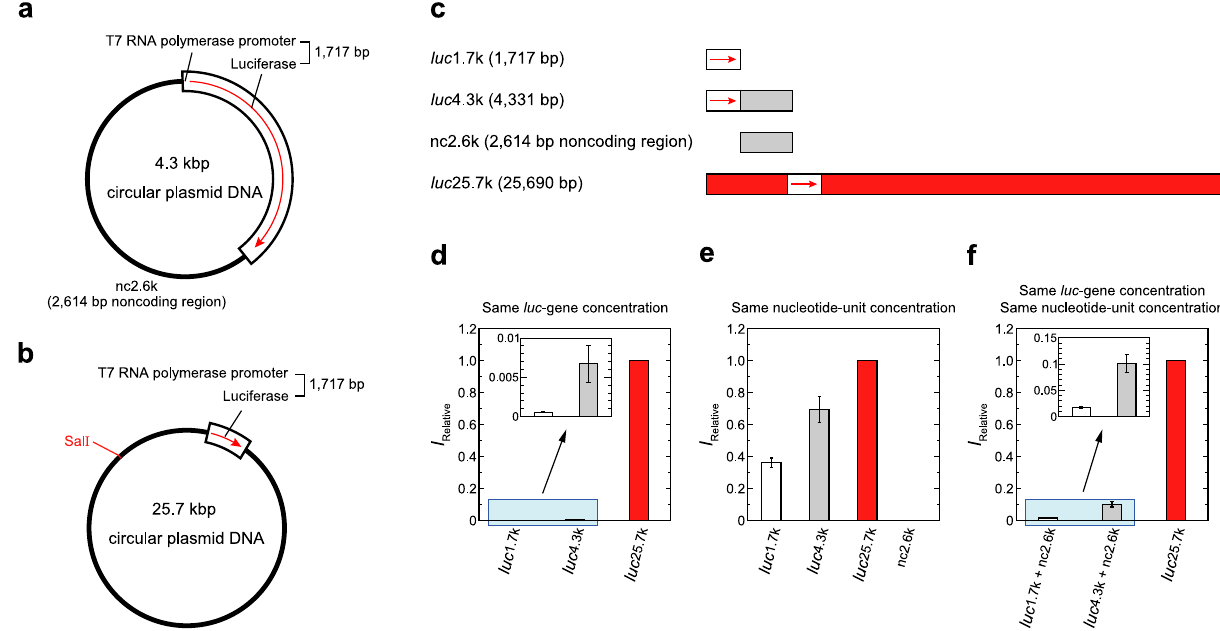
Figure 1. Effects of various factors on the efficiency of gene expression. ( a , b ) Schematic diagram of the parental 4.3-kbp and 25.7-kbp plasmid DNAs. The white box on the plasmid DNA represents a firefly luciferase reporter gene with a T7 promoter. The red arrow in the white box shows the direction of reporter gene transcription. ( c ) DNA fragments resulting from Sal I digestion of the parental 25.7-kbp plasmid or PCR amplification. Sal I yields a single 25.7-kbp linear reporter gene. A 1.7-kbp reporter gene, a 4.3-kbp reporter gene, and a 2.6-kbp non- coding DNA fragment were prepared by standard PCR. The 25.7-kbp linear reporter gene and the 2.6-kbp non- coding DNA region are colored in red and gray, respectively. ( d – f ) Efficiency, I , of the coupled transcription/ translation reaction of luc -gene, as evaluated from the change of luminescence intensity. The same luc -gene concentration (0.12 μM, d ), the same nucleotide-unit concentration (1.8 μM, e ), or a combination of both (the same luc -gene and nucleotide-unit concentration) (0.12 μM and 1.8 μM, f ) of reporter genes. In ( d–f ), the longitudinal axis shows the relative luminescence intensity normalized to that of luc 25.7 k. The relative protein expression levels with luc 25.7 k are presented as means ± SD of at least five independent